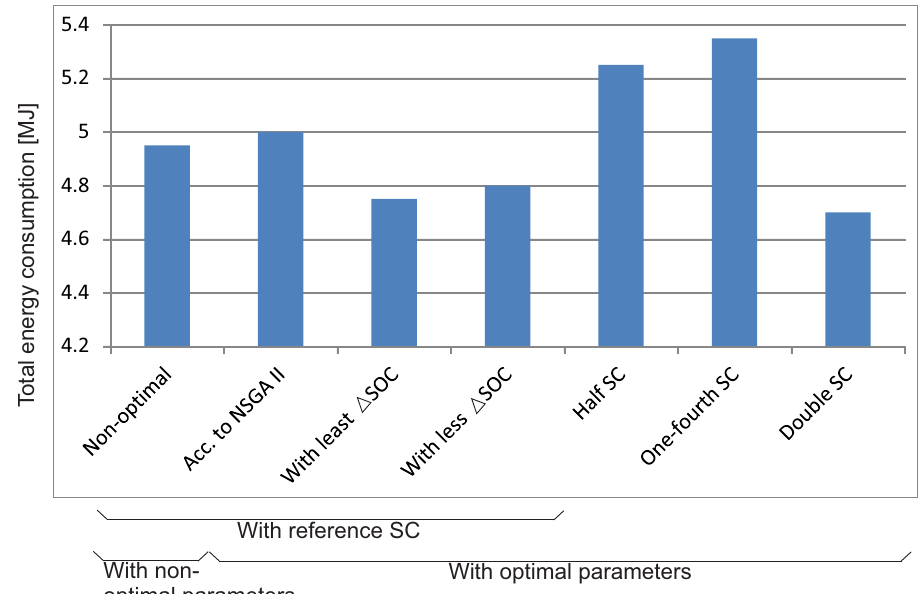
Figure 25. Comparison of all results in terms of energy